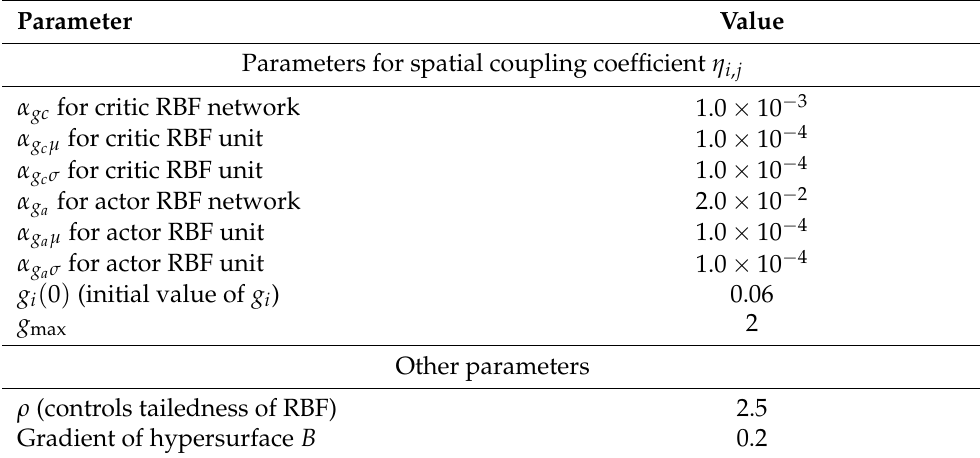
Table 3. Parameters related to η i , j and